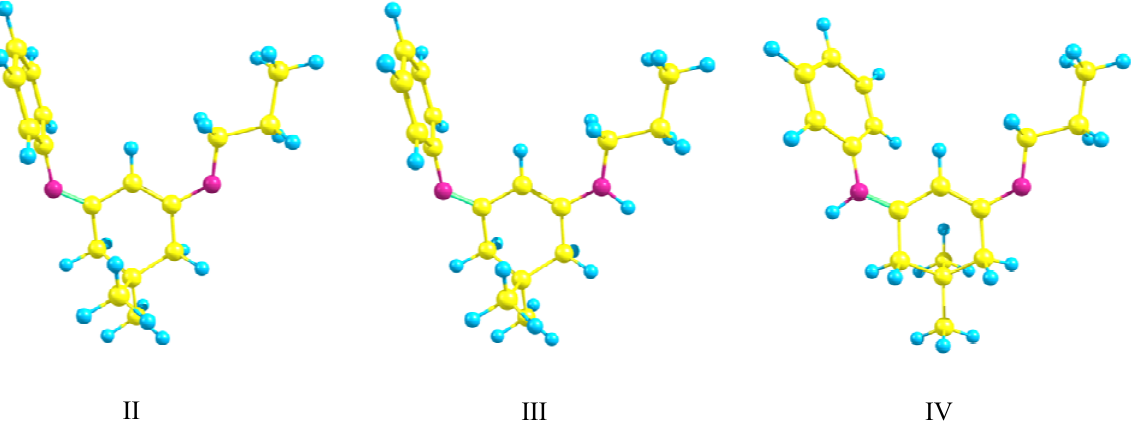
Figure 2 . DFT-calculated optimized structures of the possible tautomers for the diimine with R = n -Pr and R 1 = Ph using B3LYP/6-31G(d,p) level of theory.